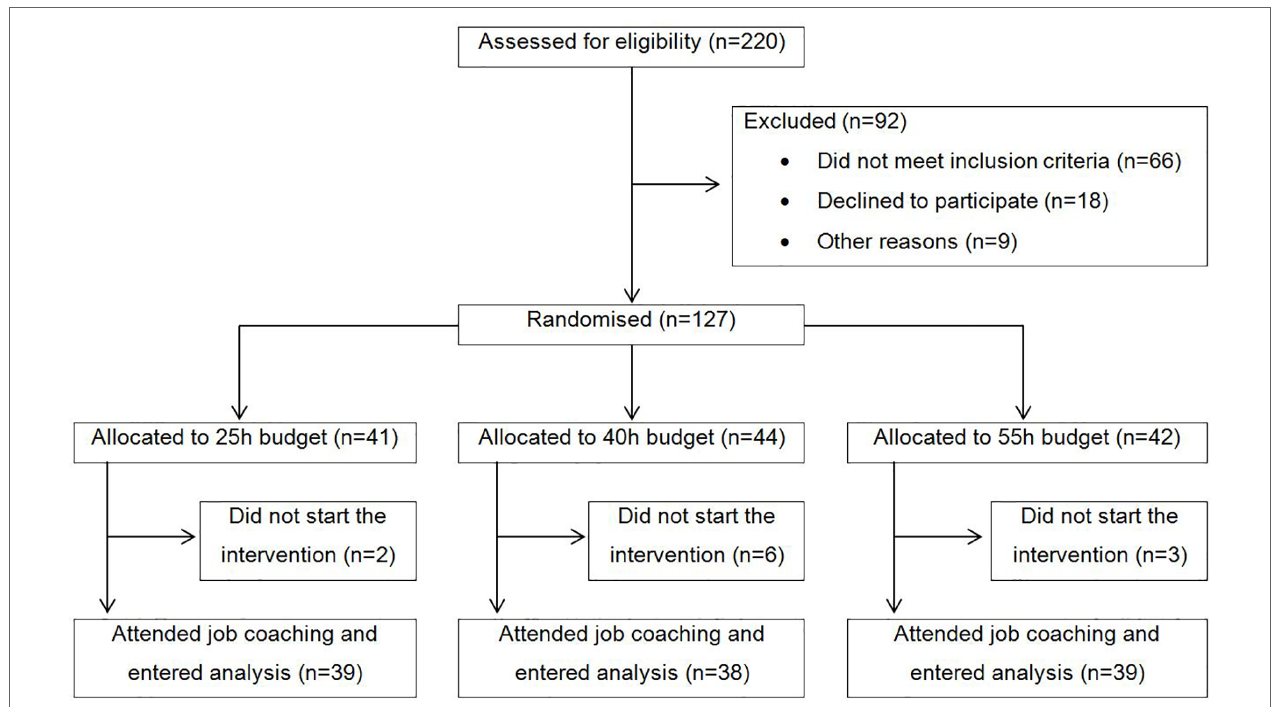
FIGURE 1 | CONSORT participant flow